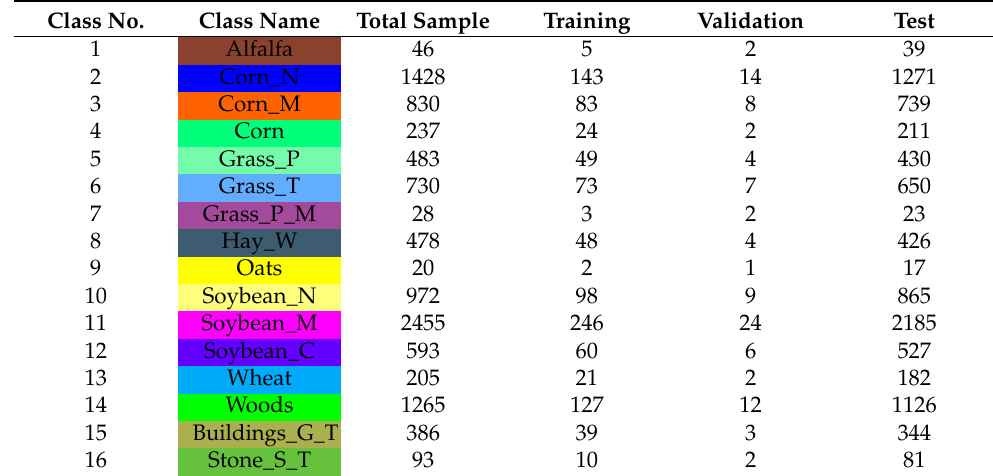
Table 1. The number of training sets and test samples covered by each surface selected on the IP dataset, and the number of all in each